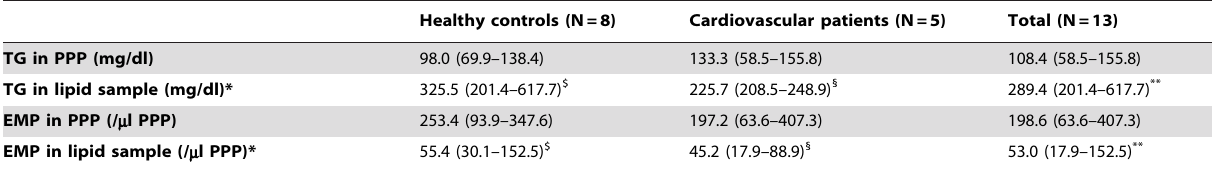
Table 1. In vitro study results.